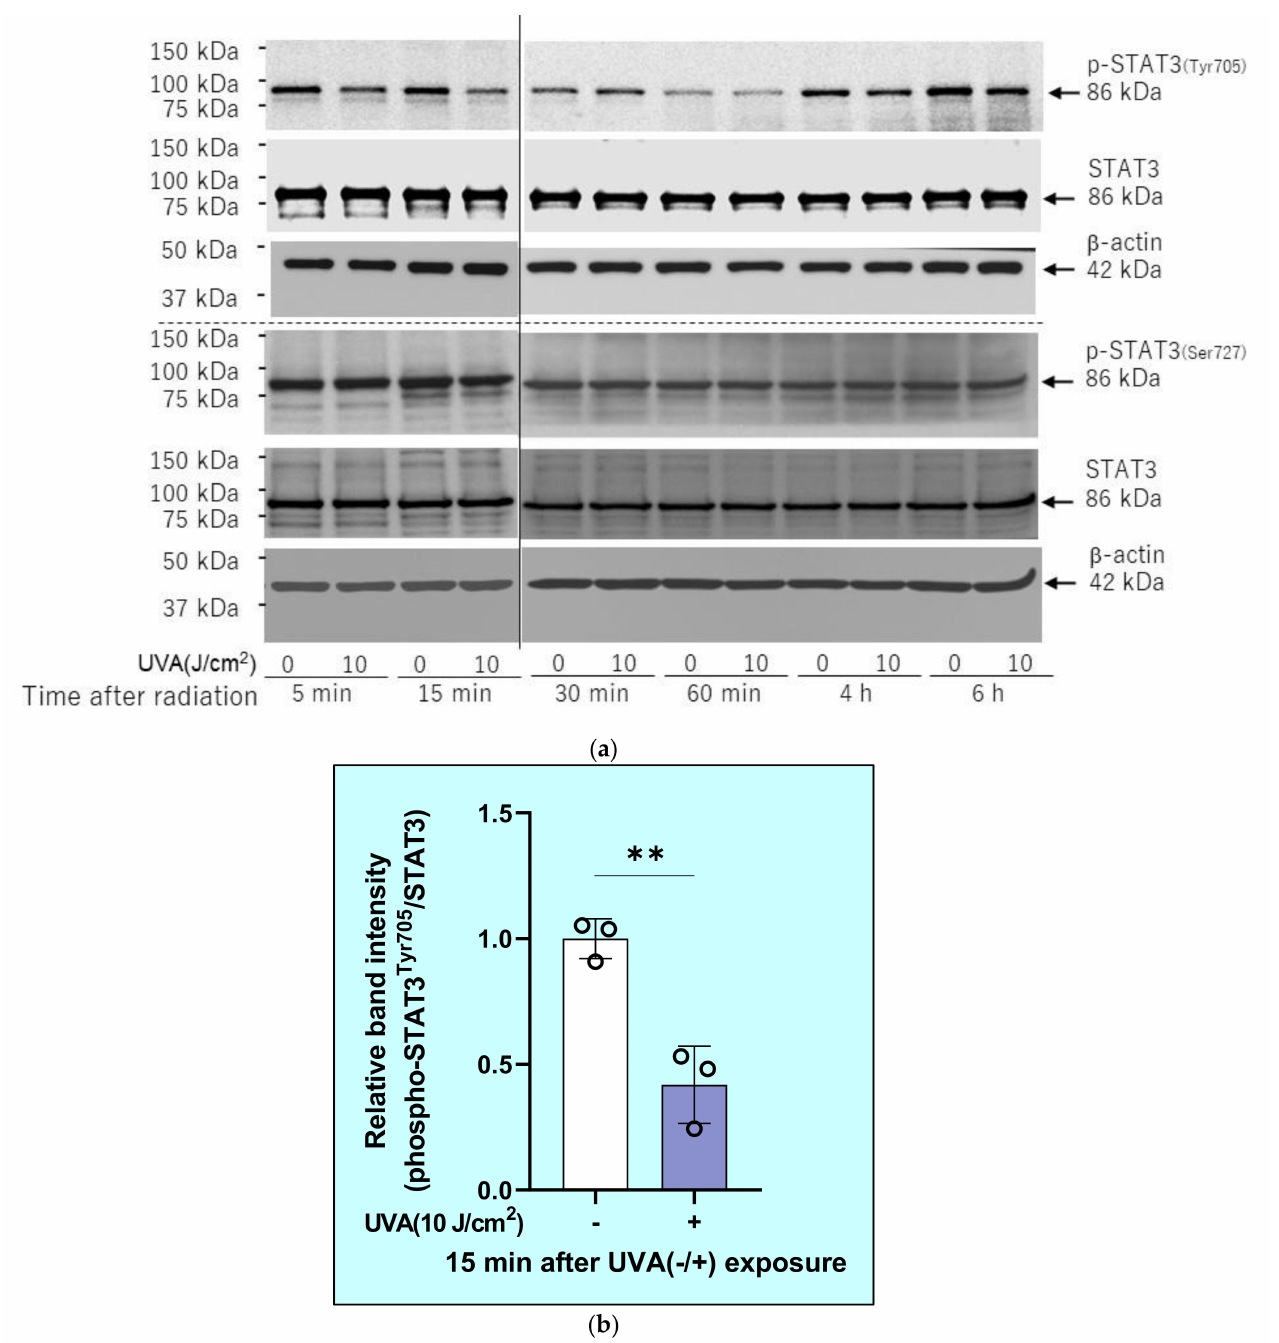
Figure 12. Effects of UVA on phosphorylation and protein levels of STAT3(Tyr705/Ser727). HDFs were exposed to UVA at the indicated doses in culture and cell lysates prepared at the indicated times post-irradiation were subjected to western blotting as described in the Materials and Methods section. Representative immunoblots from three independent experiments are shown. ( a ) Western blotting images. ( b ) Relative band intensity. Bands were quantitated and data represent means ± SD, n = 3, unpaired t -test **: p < 0.01 vs. 0 J/cm 2